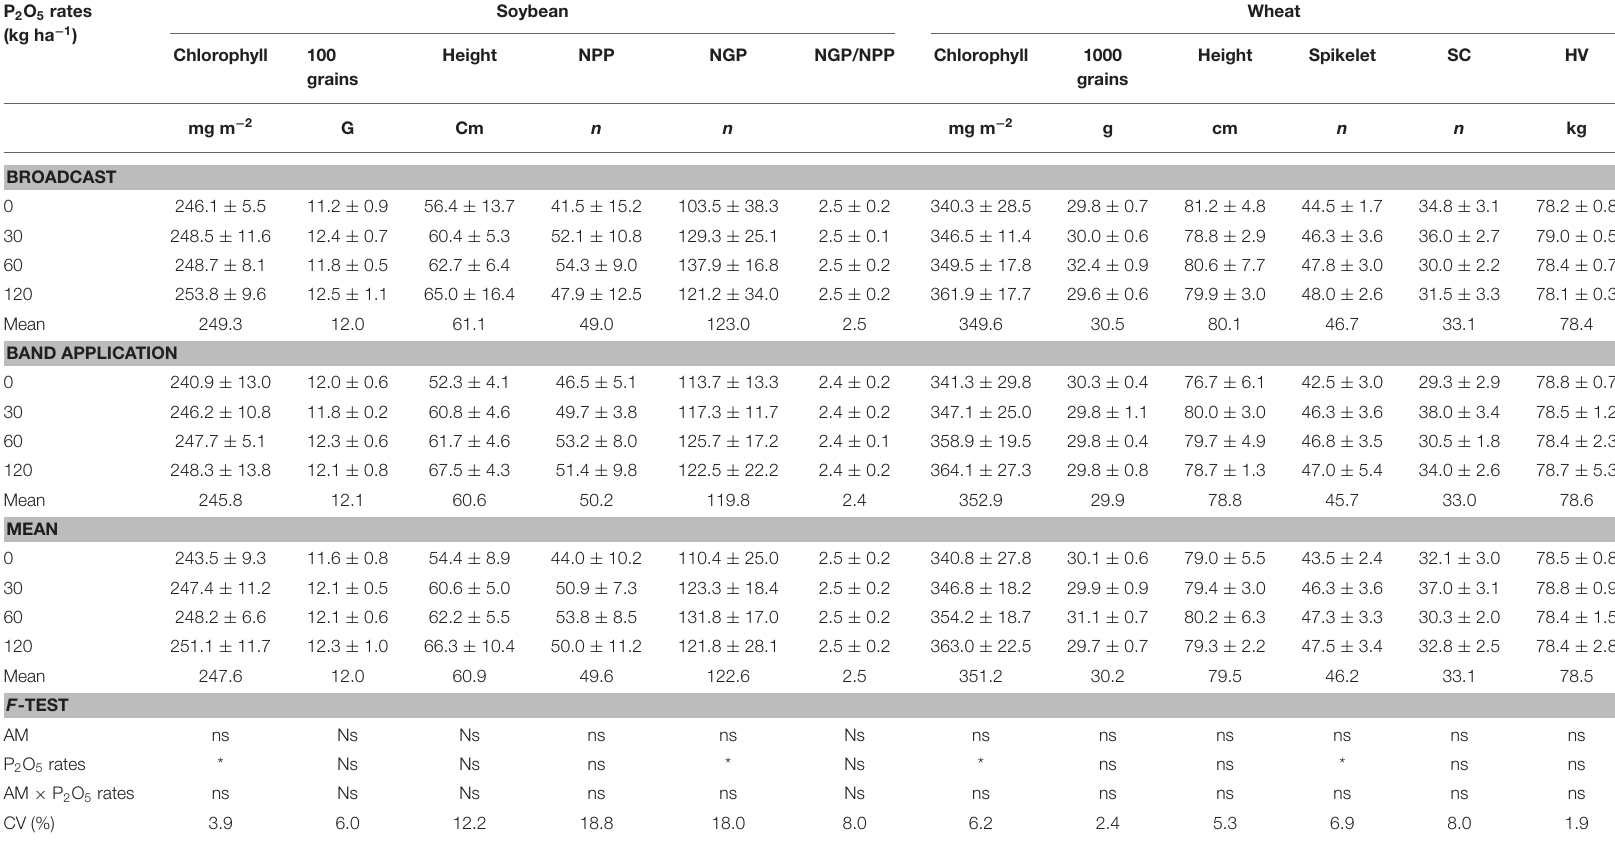
TABLE 1 | Yield components and chlorophyll level as influenced by P 2 O 5 rates, under broadcast and band application, on the average of two growing seasons of a soybean–wheat cropping system, Londrina, Paraná State,